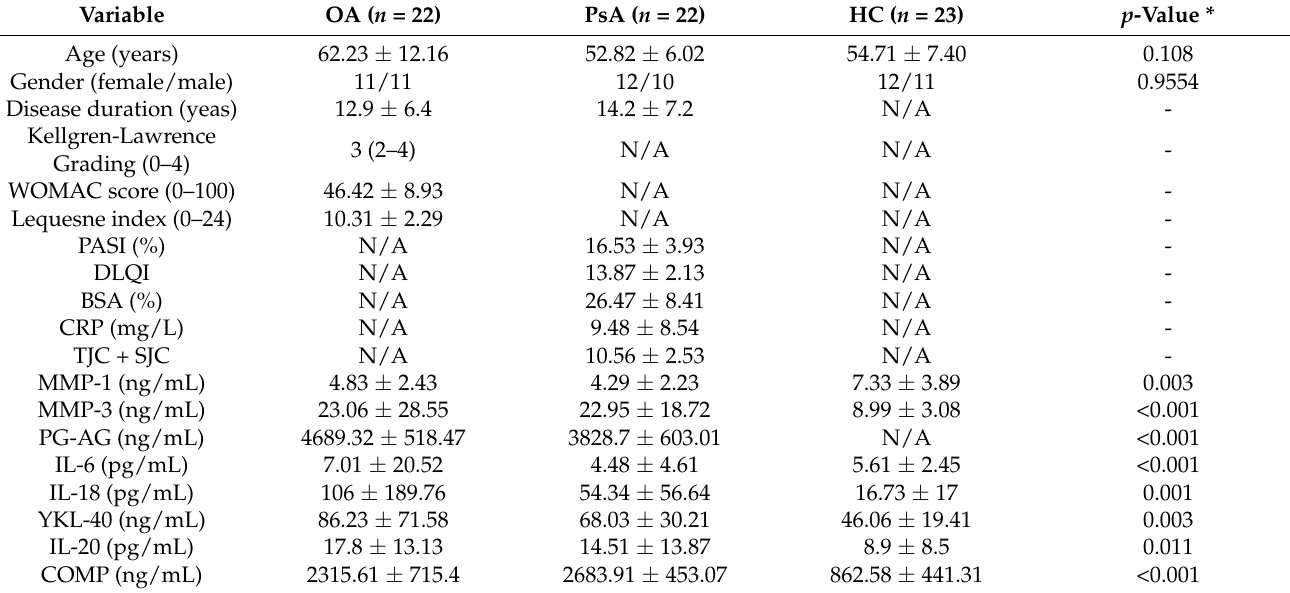
Table 1. Demographics, diseases characteristics, and serum biomarker levels in studied